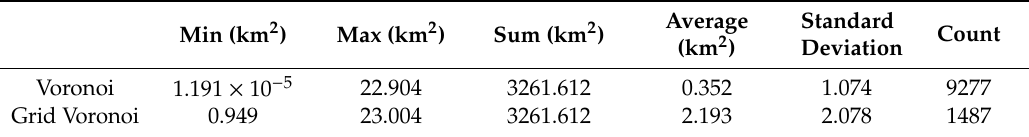
Table 4. Unit area statistics.